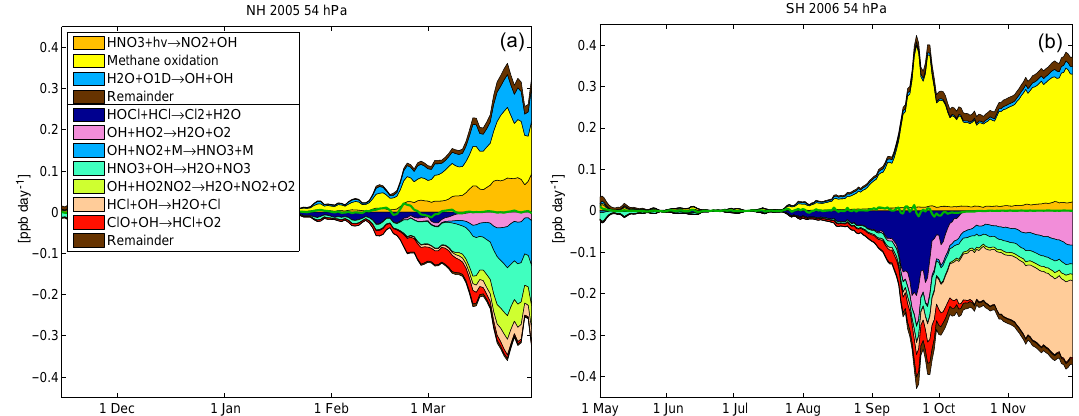
Figure 8. Vortex-averaged chemical reaction rates of reactions changing extended HO x (OH + HO 2 + H + HOCl + HOBr + HO 2 NO 2 ) for the Arctic winter 2004–2005 (a) and the Antarctic winter 2006 (b) at 54hPa. Production reactions are shown as positive and are separated by a line in the legend from the loss reactions, which are shown as negative. The net change of extended HO x is shown as a green line. Methane oxidation is modeled by simplified net reactions in ATLAS, the reactions denoted as methane oxidation in the legend are Cl + CH 4 → HCl + CH 2 O + HO 2 and Cl + CH 2 O → HCl + CO + HO 2